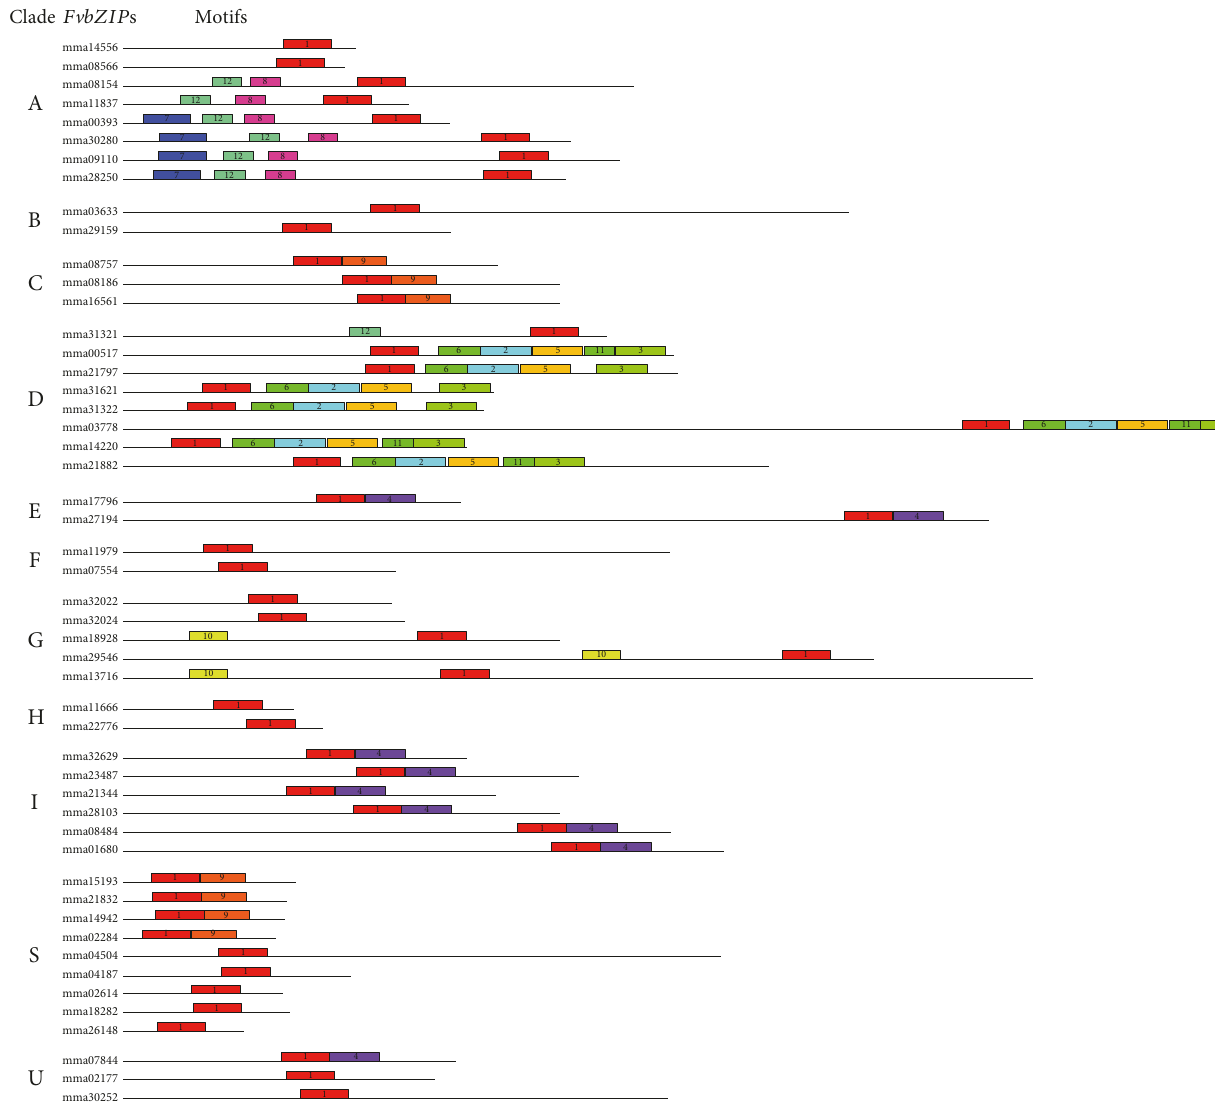
Figure 3: Summery for the distribution of conserved motifs identi fi ed from FvbZIP proteins by each clade given separately. Each motif is represented by a number in colored box. See Supplementary Table S 1 for detailed motif